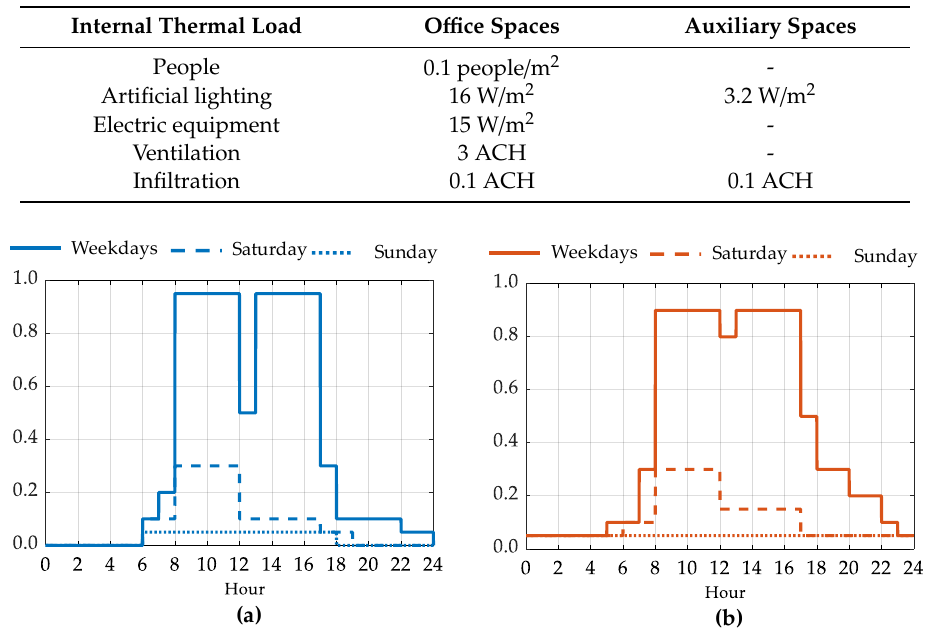
Figure 2. Schedules for ( a ) occupancy and ( b ) lighting and electric equipment use according to the ASHRAE 90.1 standard expressed as a percentage of the maximum load.